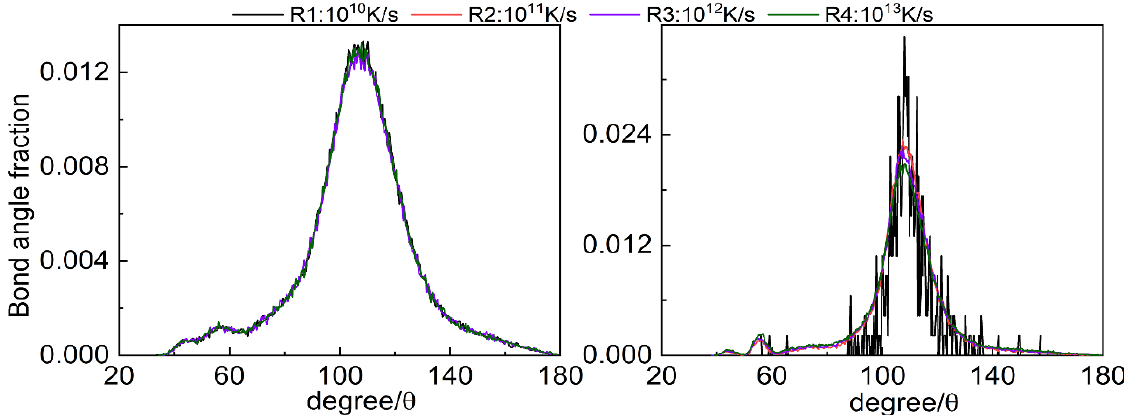
Figure 4. Bond angle distribution function for different cooling rates at 3500 K and 200 K.